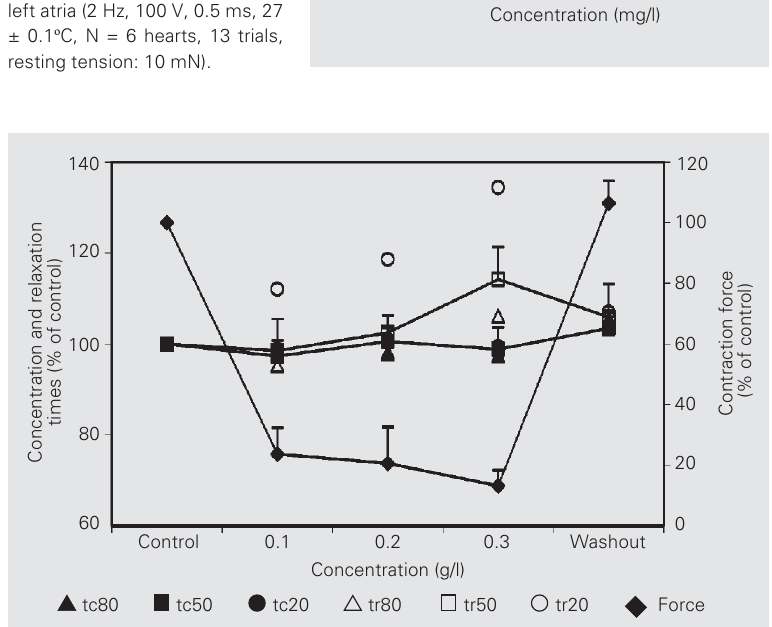
Figure 2. Hill-Langmuir plots con- structed to estimate the potency of acetic acid (squares, EC 50 = 0.07 g/l, Hill constant = 1.2), crude (diamonds, EC 50 = 1.4 g/l, Hill constant = 2), and ethanol extracts (triangles, EC 50 = 4.5 g/l, Hill constant = 3) of Psidium guajava L. The experiments were carried out on paced guinea pig left atria (2 Hz, 100 V, 0.5 ms, 27 ± 0.1 (cid:1) C, N = 6 hearts, 13 trials, resting tension: 10 mN).